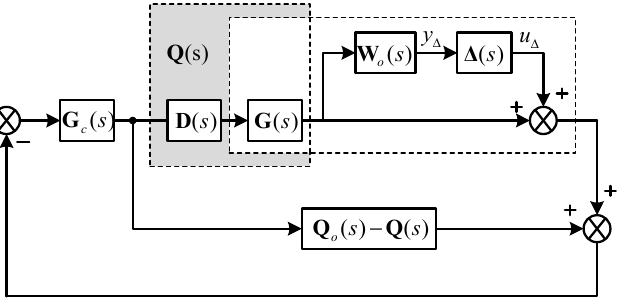
Figure 6. DSP structure with multiplicative output uncertainty.